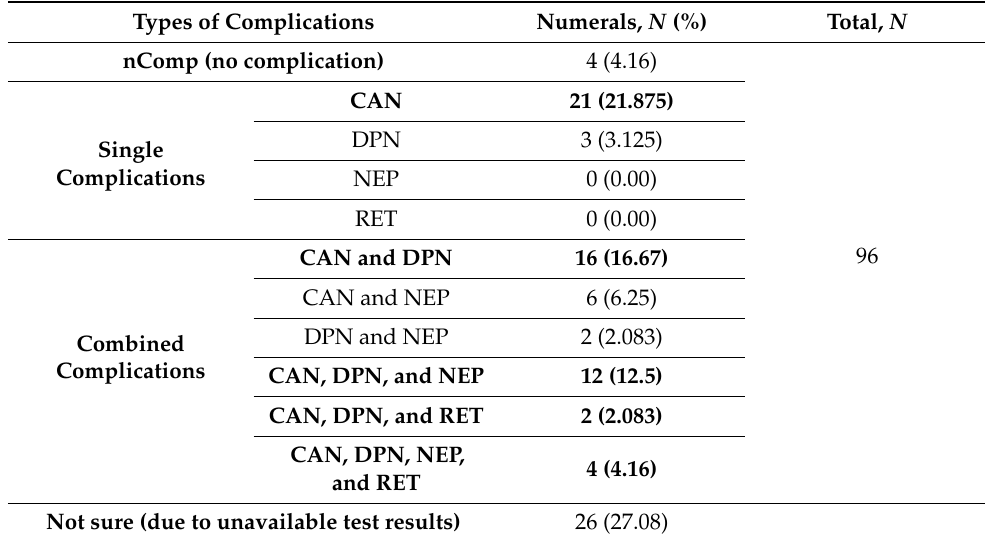
Table 2. Types and frequency of complications of diabetes patients.